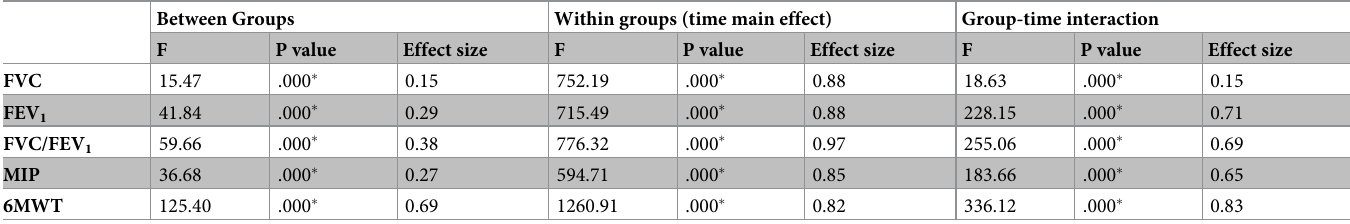
Table 3. Repeated measure ANOVA within subjects and between groups comparison. Between Groups Within groups (time main